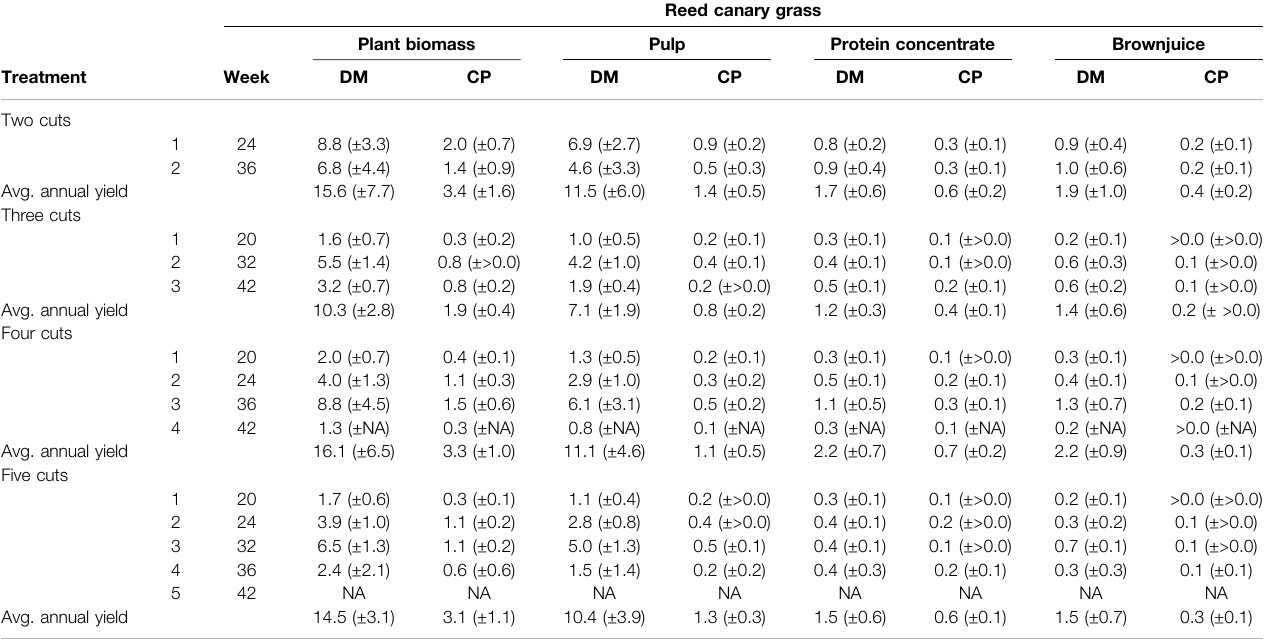
TABLE 3 | Dry matter (DM) and crude protein (CP) yields in plant biomass and screw-pressed fractions for reed canary grass. All yields in t ha − 1 year − 1 . Standard deviation (SD)isgivinginbrackets.MissingSDvaluesduetoonlyonereplicateasaconsequenceofinsuf fi cientbiomassforprocessing.NA ’ sduetoalackofsuf fi cientbiomassfor processing with the